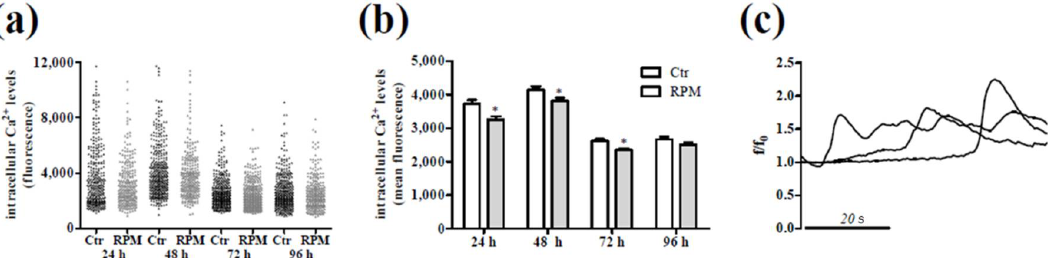
Figure 3. Intracellular Ca 2 + signalling in single Jurkat cells grown under standard (at 1 g, Ctr) or s-microgravity (RPM) conditions. ( a ) Intracellular Ca 2 + levels recorded in single cells and expressed as fluorescence intensity. ( b ) The mean basal level of Ca 2 + expressed as fluorescence mean intensity. Values are presented as means ± SEM. * p < 0.05 compared with the corresponding Ctr. ( c ) Representative spontaneous calcium variations that can be recorded in single cells from both Ctr ( n = at least 312) and RPM exposed ( n = at least 254) samples. Table 1. Quantitative analyses of the spontaneous intracellular Ca 2+ variations. Oscillating Cells Time (% ± SEM)